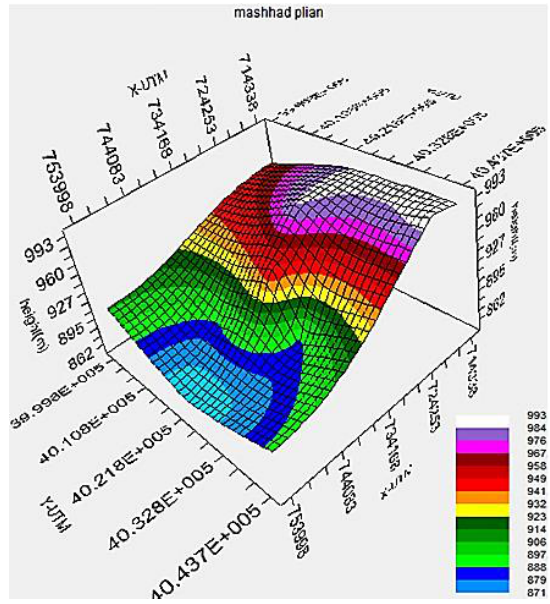
Fig 7. groundwater level forecasting in study